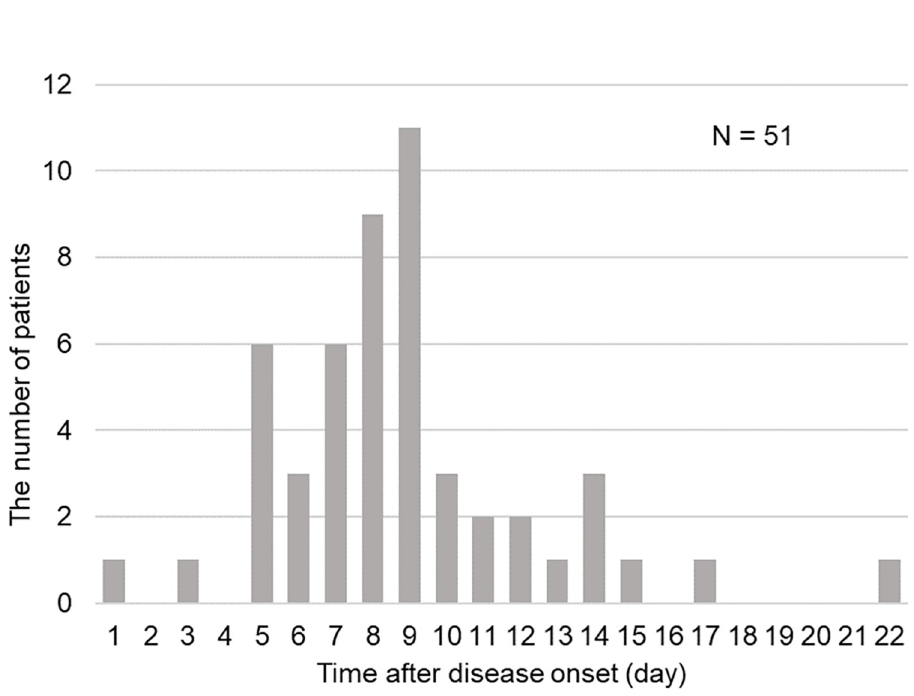
Fig 3. First appearance of atypical lymphocytes after disease onset. Patients were counted according to the day of the first identification of atypical lymphocytes after disease onset. The total number of patients who had atypical lymphocytes in their peripheral blood was 51. The median value was eight